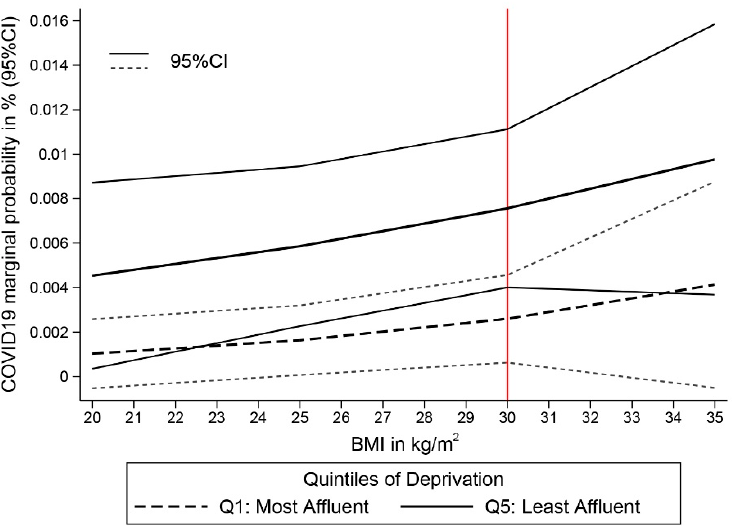
Figure 3. Probabilities of COVID-19 Testing Positive among UK Biobank Incident Cancer Patients by deprivation (most affluent vs. least affluent) and BMI in kg/m 2 ( N = 18,917, 89 cases).